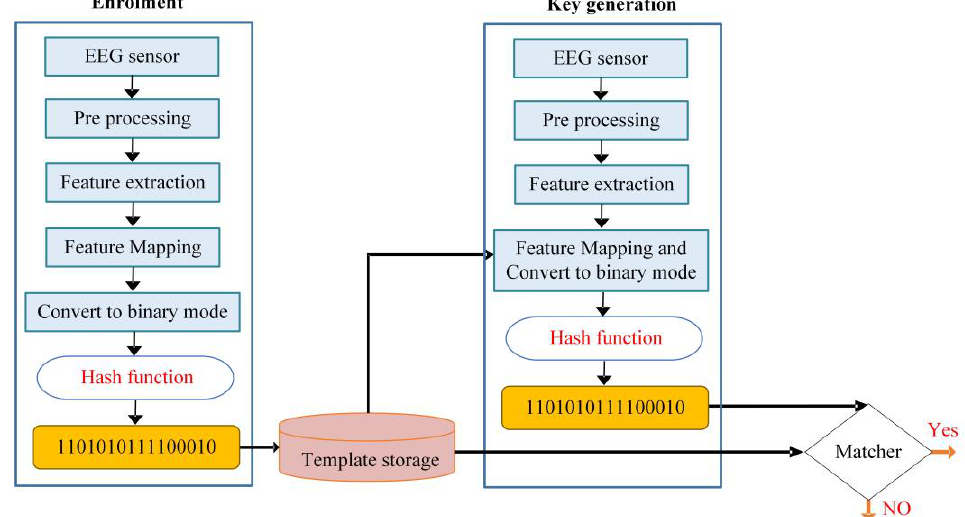
Figure 1. Flow of key generation from EEG of the